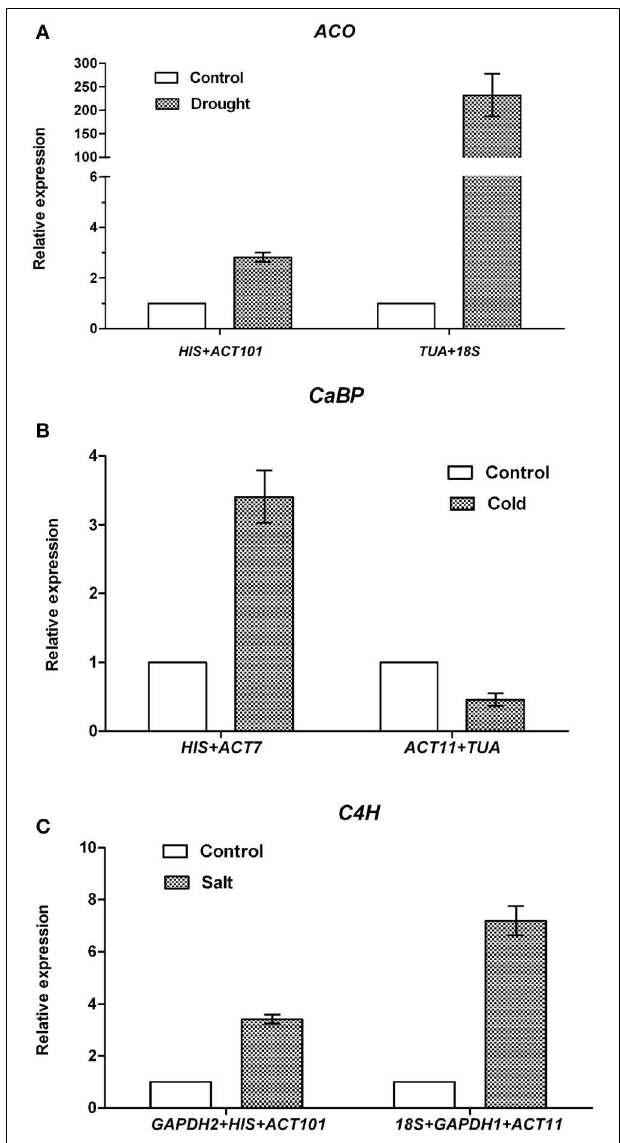
FIGURE 4 | Normalized expression level of ACO, CaBP and C4H . (A) Relative quantification of ACO expression using by the best stable genes ( ACT101 and HIS) , and the least stable genes ( TUA and 18S ) under drought treatment. (B) Relative quantification of CaBP expression by the best stable genes ( HIS and ACT7), and the least stable genes ( ACT11 and TUA ) under cold treatment. (C) Relative quantification of C4H expression by the best stable genes ( GAPDH2 , HIS , and ACT101), and the least stable genes ( 18S, GAPDH1 , and ACT11 ) under salt treatment. The average Ct value was calculated from three biological and technical replicates and used for relative expression analyses. Error bars indicate standard